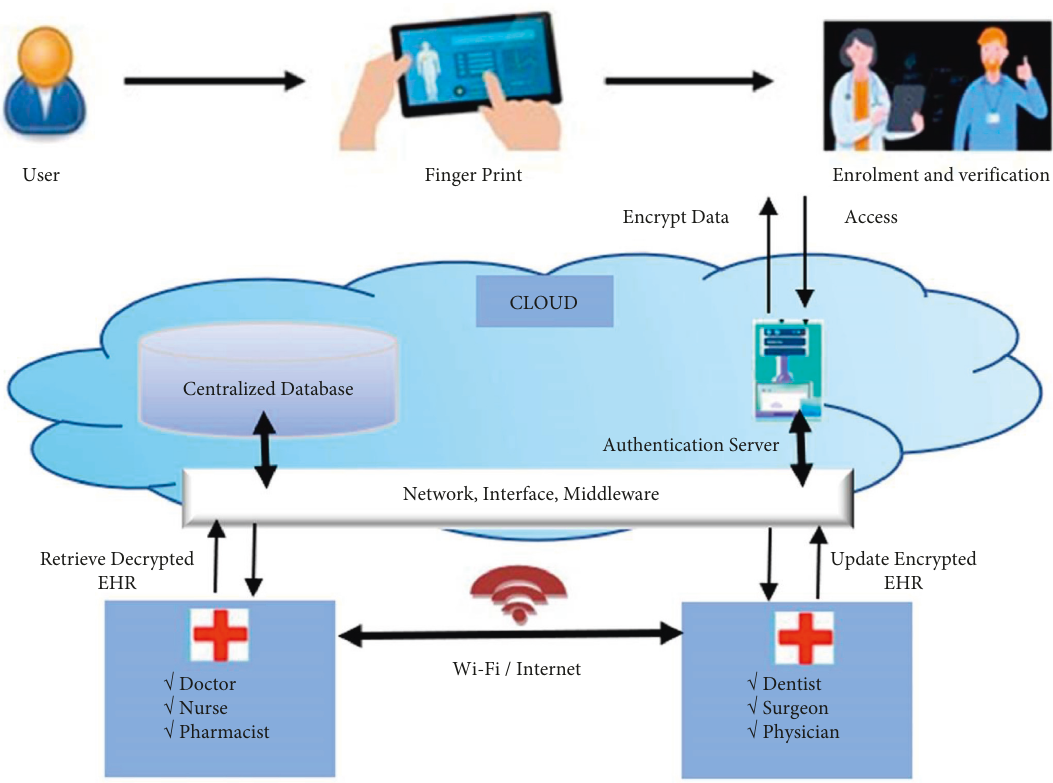
Figure 6: Cloud-based